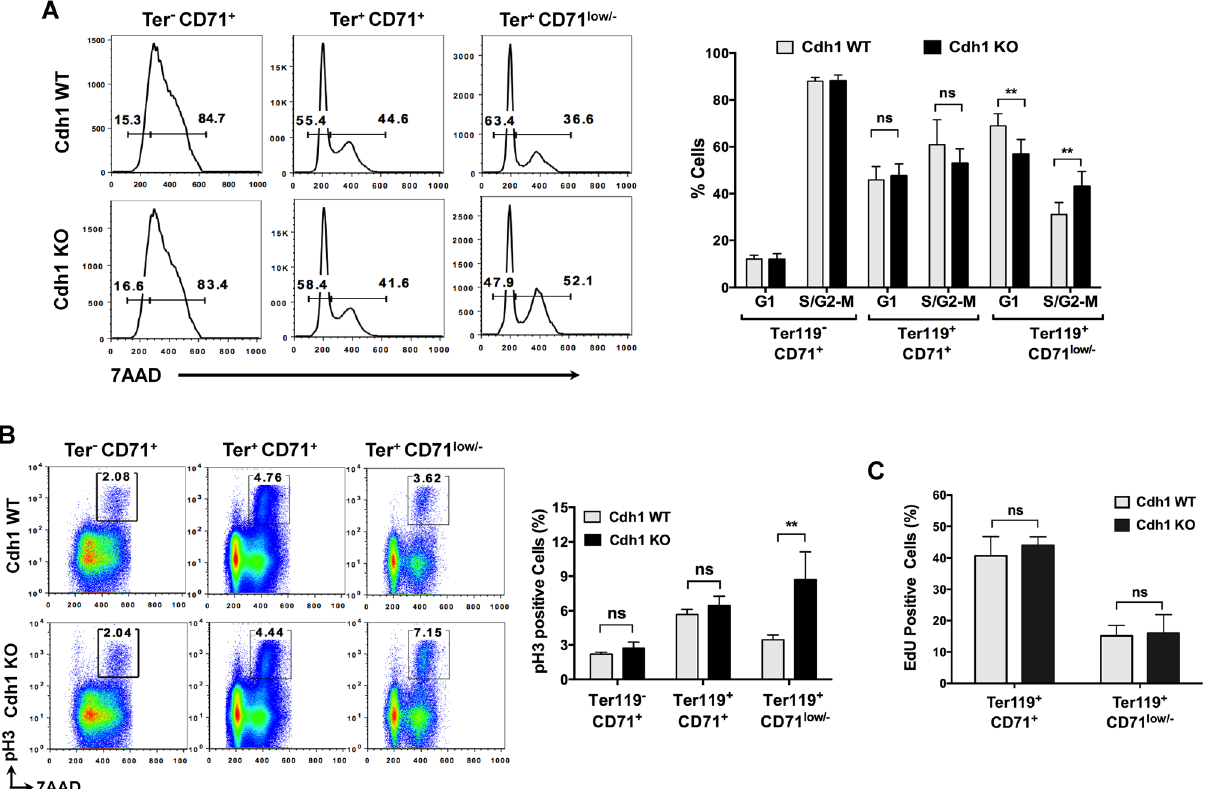
Figure 4. Cell cycle defects in fetal liver erythroblasts devoid of Cdh1. ( A ) Fetal liver cells from E17.5 control (Cdh1-WT) and Cdh1-null (Cdh1-KO) embryos were stained for Ter119 and CD71 surface markers and DNA content was analyzed in the indicated populations. The percentage of cells with 2N DNA content (G1) or with higher-than-2N DNA content (S/G2-M) was measured and plotted (right panel; n = 5). Representative cell cycle profiles are shown (left panels). ( B ) Quantitation of pH3 positive cells in the different erythroid populations gated based on Ter119 and CD71 expression, from control and Cdh1-deficient E17.5 fetal livers (n = 5). Examples of flow cytometry plots showing the quantified region are included on the left. ( C ) The percentage of EdU positive cells was assessed in sorted Ter119 + CD71 + and Ter119 + CD71 low/- erythroblast populations from control (Cdh1-WT) and Cdh1-null (Cdh1-KO) E17.5 fetal livers (n = 4). ** P < 0.01, ns (not significant) P >